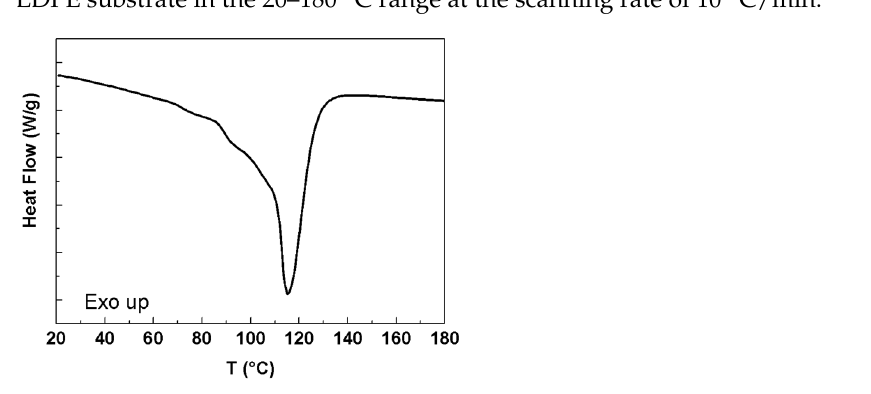
Figure 5. DSC heating curves of a LDPE sample in the 20–180 °C temperature, T, range at the rate of 10 °C/min.